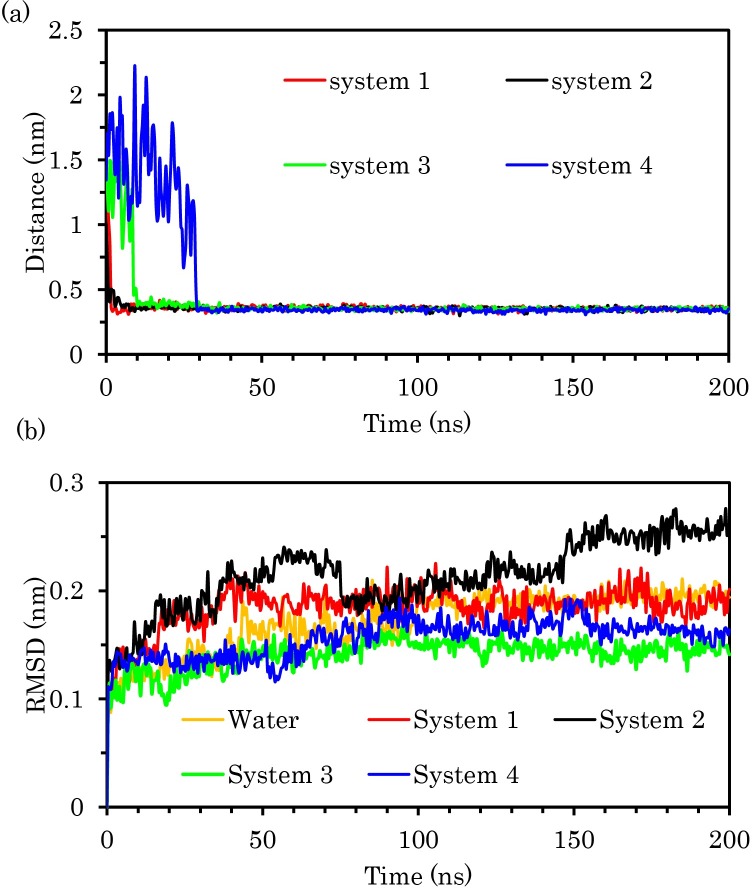
(a) Center of mass (COM) distances between the enzyme and COOH-f-DWCNT as a function of time (b) The RMSD of C-α of trypsin during the simulation time.